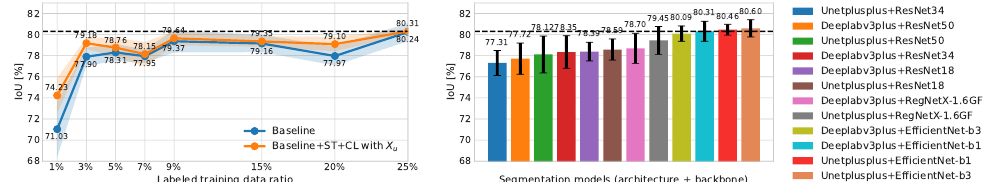
Figure 5. Comparison between our proposed method and pixel-wise segmentation models on the BCSS dataset. Left: IoU values of PSeger trained on different ratios of labeled training data by two training strategies ( Baseline , Baseline+ST+CL with X u ). Right: IoU values of different segmentation models trained on the full training set. The values of the black dotted lines in the left and right are both 80.31, representing the IoU that PSeger (trained by Baseline+ST+CL with X u on the training set with 25% labeled data) and the third-best segmentation model (DeepLabv3plus+EfficientNet-b1) have